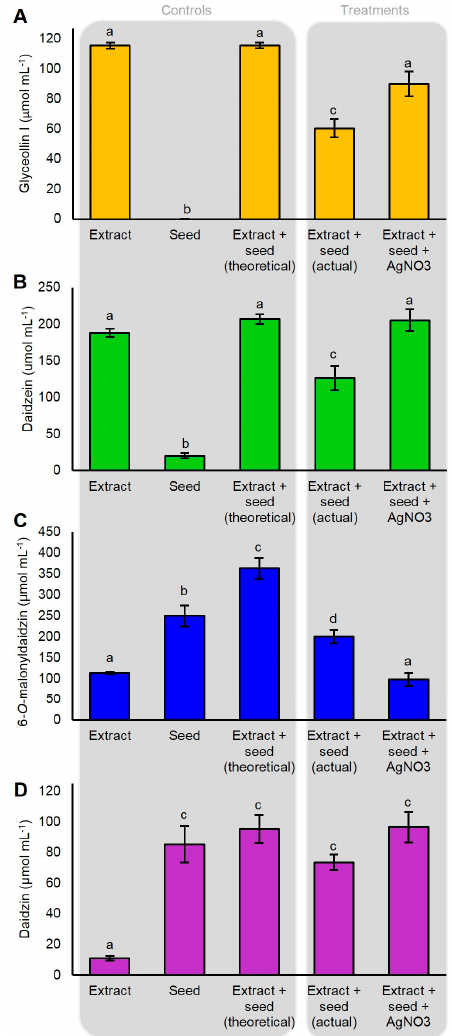
Figure 6. Degradation of externally supplied glyceollin I ( A ); daidzein ( B ); 6 ″ - O -malonyldaidzin ( C ); and daidzin ( D ) by soybean seeds. Isoflavonoids were partially purified from an ethanolic extract of WGE-elicited soybean seeds, and were incubated with imbibed soybean seeds pretreated with AgNO 3 or water to test for effects on metabolite degradation. Shown is the amount of metabolite from the initial partially purified ethanolic extract (Extract), the amount from imbibed seeds in incubated in water only (Seed), the theoretical amount from empirically adding the values from Extract and Seed (theoretical), the amount observed from incubating the seed in water for 2 h followed by metabolite extract for 4 h (actual), or from incubating the seed in 5 mM AgNO 3 for 2 h followed by metabolite extract for 4 h (Extract + seed + AgNO 3 ). Two-way ANOVA, Tukey post hoc test ( p < 0.001). The results represent four biological replicates. Different letters show significant differences by ANOVA